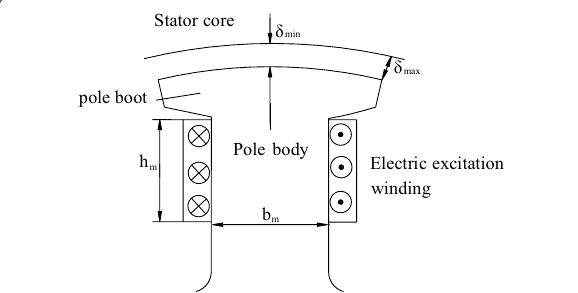
Figure 5 Magnetic pole shape of salient-pole electrical excitation